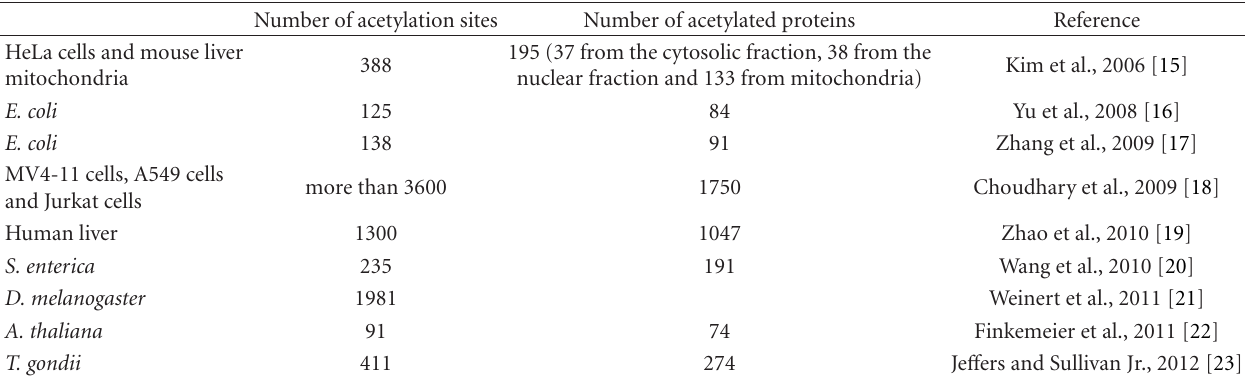
Table 1: Acetylomes from di ff erent